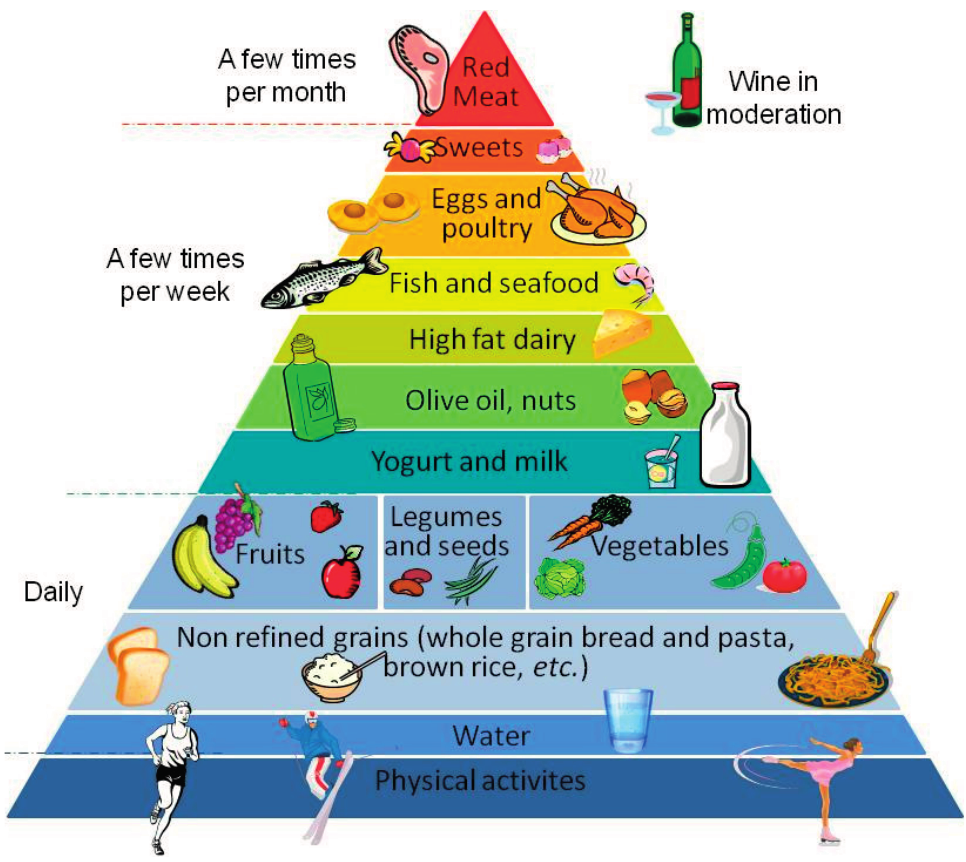
Figure 1. Pyramidal representation of Mediterranean dietary patterns (MDPs) and the frequency of recommended